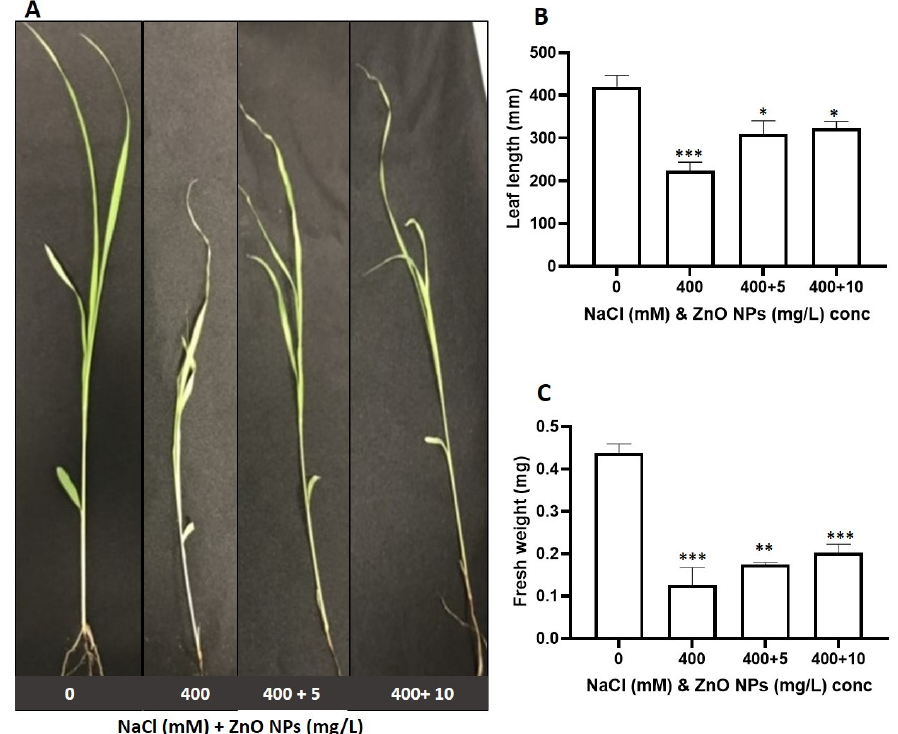
Figure 2. Effect of salt and the priming of the ZnO NPs on the growth parameters of sorghum. ( A ) Visual image, ( B ) shoot length, and ( C ) shoot fresh weight of sorghum plants in response to salt and the priming of the ZnO NPs. Error bars represent the SD calculated from three biological replicates. Statistical significance between the control and treated plants was determined by a two-way ANOVA performed on GraphPad 9.2.0, shown as *** = p ≤ 0.001 ** = p ≤ 0.01, and * = p ≤ 0.05 according to the Bonferroni’s multiple comparisons test.